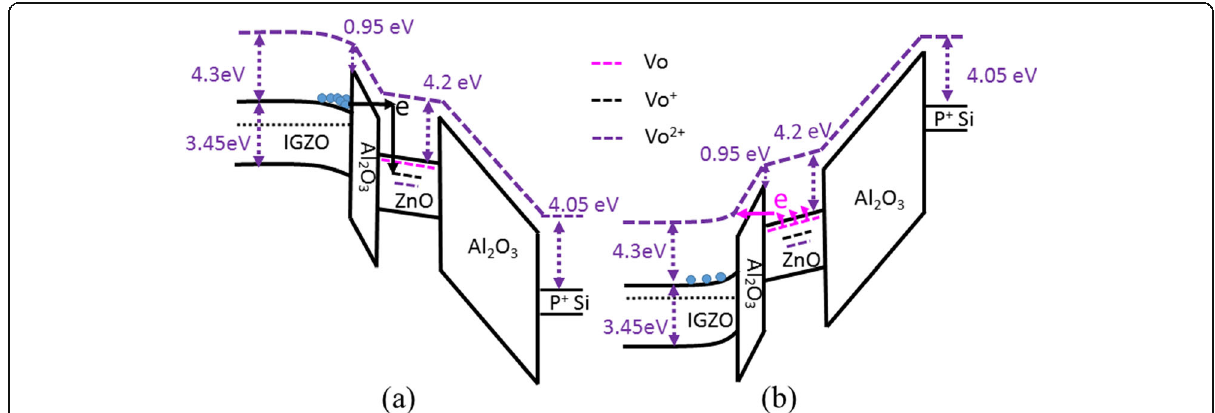
Fig. 8 Energy band diagrams of the a-IGZO TFT memory devices programmed at a a positive gate bias and b a negative gate bias, respectively. V o , V o+ , and V o2+ denote neutral oxygen vacancy, singly ionized oxygen vacancy, and doubly ionized oxygen vacancy,